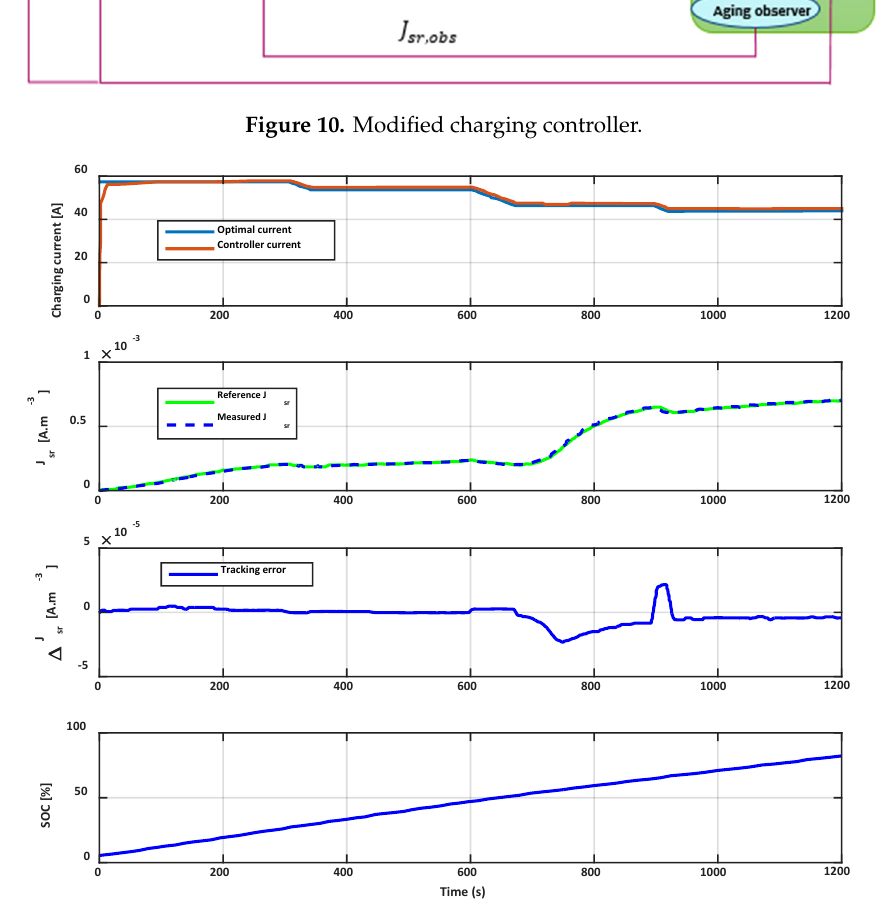
Figure 11. Validation of the modified control scheme’s proper operation.